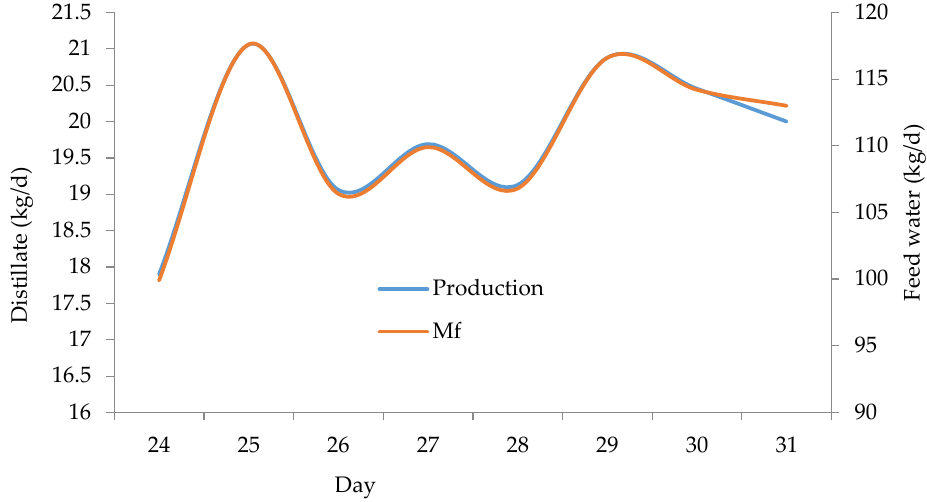
Figure 8. Variations of total distillate production rate and feed water.